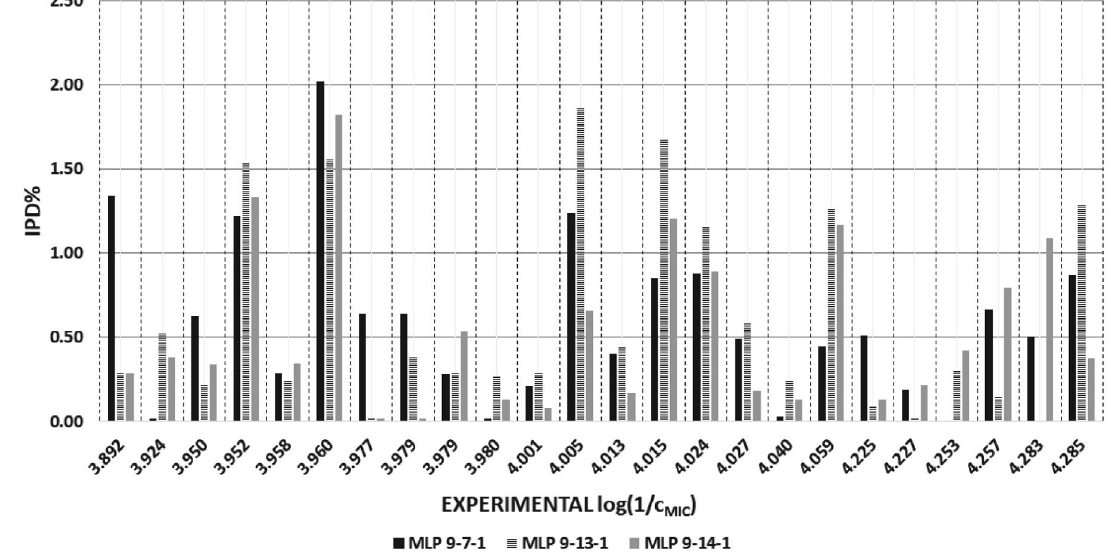
Figure 6. Individual percentage deviations (IPD%) of predicted values compared with the experimental